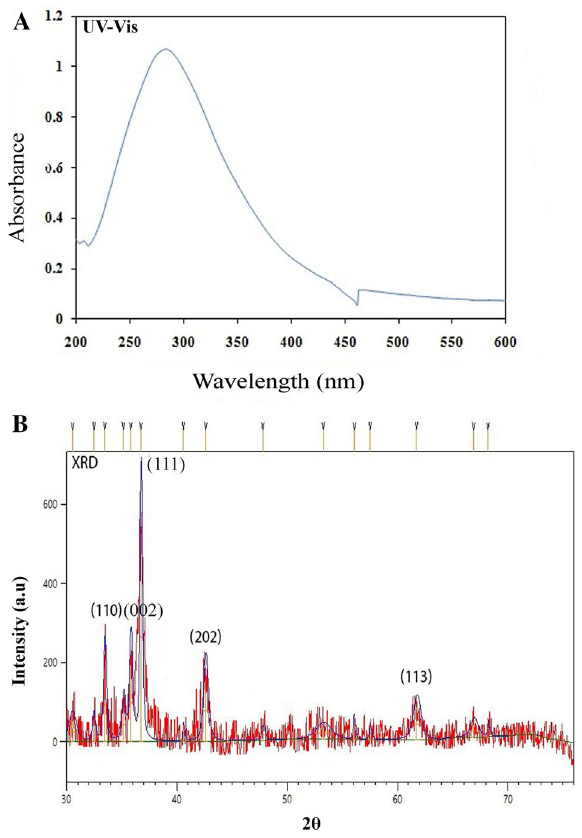
Figure 2. ( A ) UV–visible spectrum, ( B ) XRD graph of BC-CuONPs.